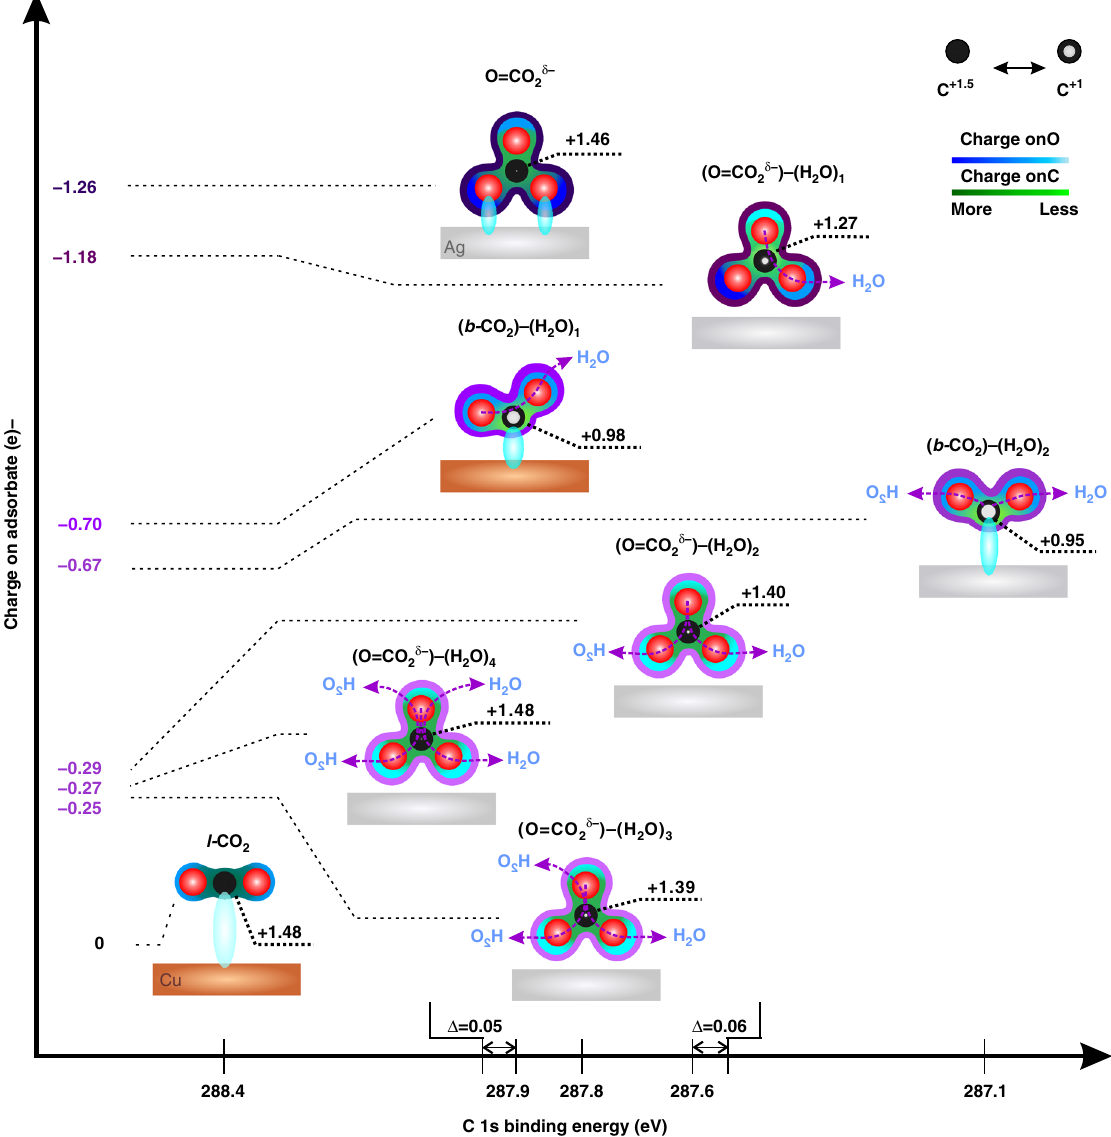
Fig. 4 The electronic properties of various surface adsorbates on Ag and Cu. The charge distribution on the C, O and the adsorbates are summarized, with the corresponding C 1 s BE revisited. The various con fi gurations of the adsorbates on the surface modify the charge transfer process, leading to different charge distribution on the adsorbates. Compared to l- CO 2 (only observed on Cu surface), CO 2 in the bent con fi guration exhibits extra charge accumulation. b- CO 2 is stabilized on Ag only with two surface H 2 O but the charge distribution is similar to b- CO 2 on Cu surface. However, their different distances to the Ag and Cu surface lead to different C 1 s peak BE ’ s. With the formation of the fi rst two HBs to surface H 2 O, the total charge on O = CO 2 δ − decreases, which decreases the C 1s BE by ~0.30 eV. But adding the 3rd and 4th H 2 O with HB to the C = O up of the O = CO 2 δ − increases the charge, shifting the BE back to 0.05 eV above the peak for no H 2 O. Thus the predicting C 1 s shifts and charge distribution on surface adsorbates are fully consistent with the experimental observed C 1 s BEs. These observed differences show the tunability of CO 2 adsorption on the metal